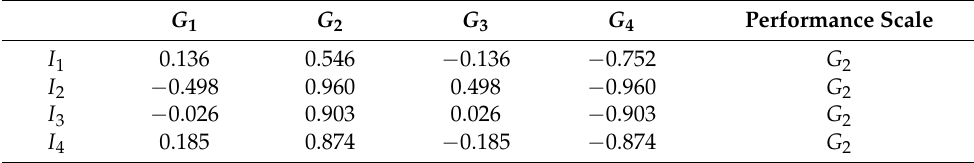
Table 9. The synthetic connection degree of each first-level